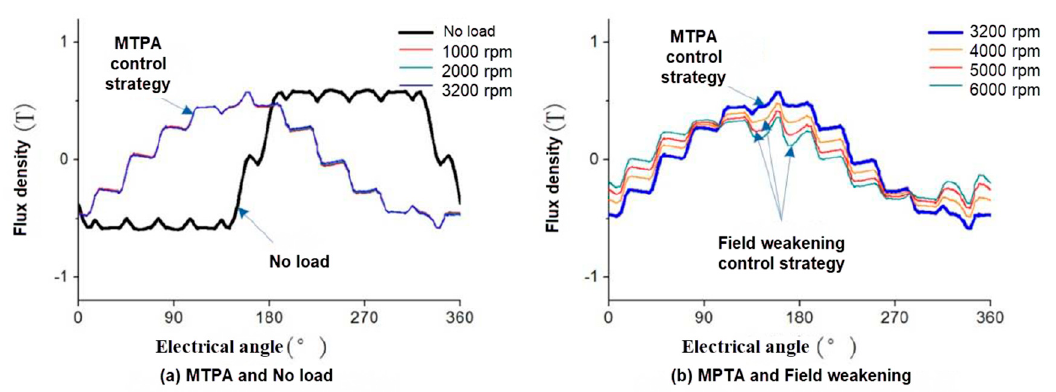
Figure 7. The air gap flux density under the armature reaction without considering the magnetic field of the permanent magnet.